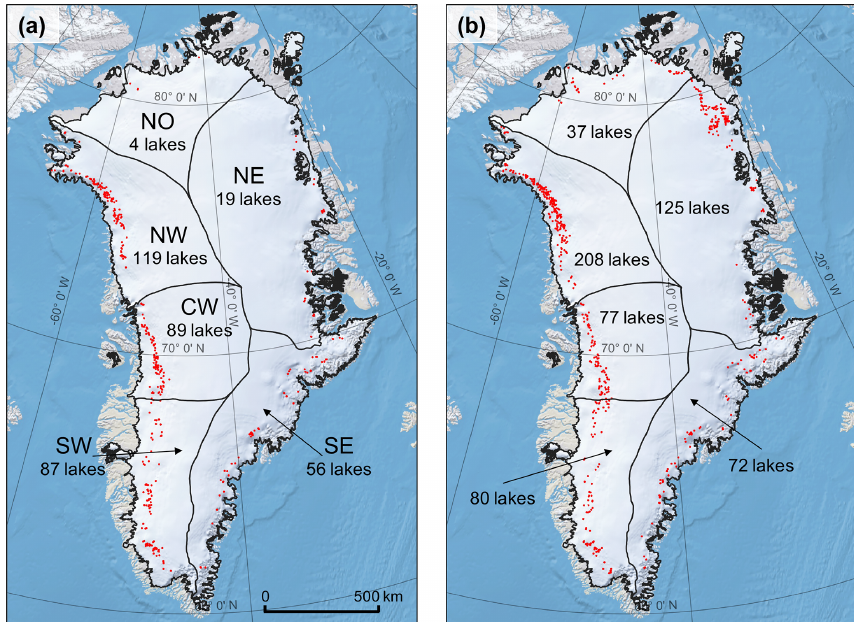
Figure 3. Buried lake distributions, shown in red. (a) The 2018 buried lakes with major GrIS drainage basins labelled (Rignot and Mouginot, 2012). (b) The 2019 buried lakes. The background map is from